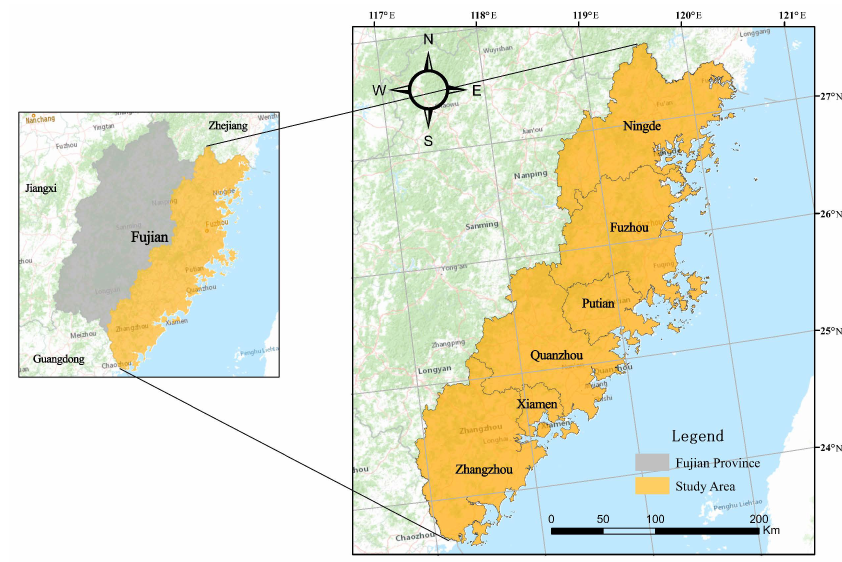
Figure 1. Geographical location and administrative division of Fujian Coastal Areas.